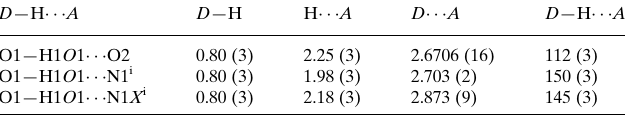
Hydrogen-bond geometry (A˚ , (cid:2)